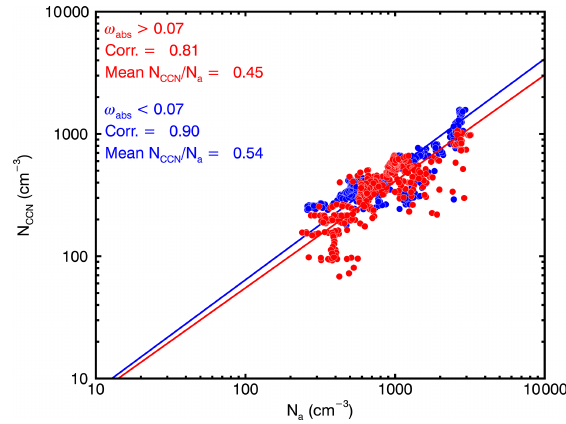
Figure 6. Relationship between N CCN and N a under the strongly absorptive aerosol regime (in red) and the weakly absorptive aerosol regime (in